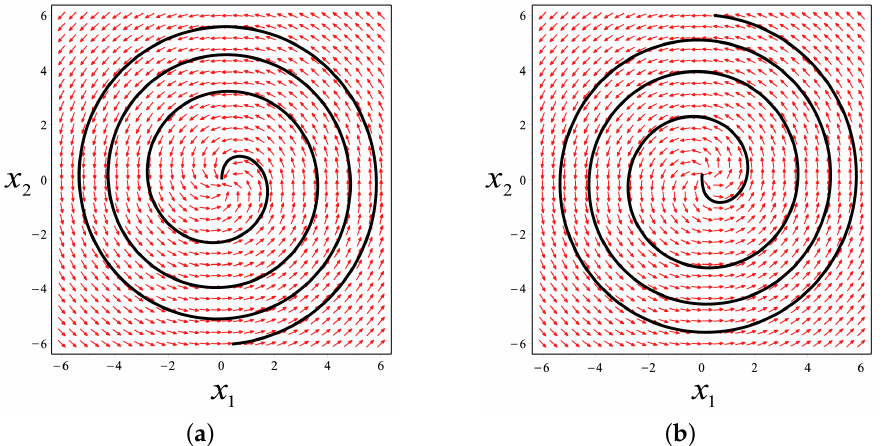
Figure 2. Trajectories on ( x 1 , x 2 ) plane: ( a ) Stable region; ( b ) Unstable